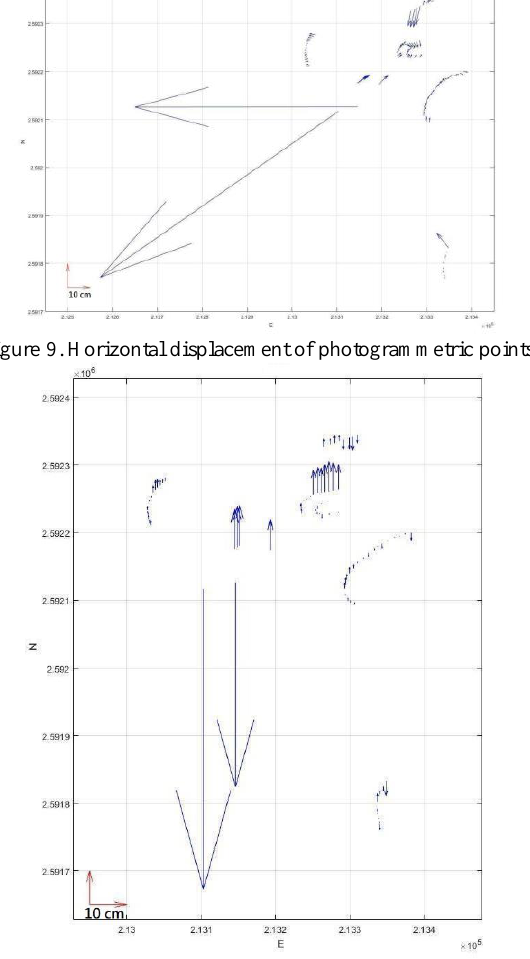
Figure 10. Vertical displacement of photogrammetric points.